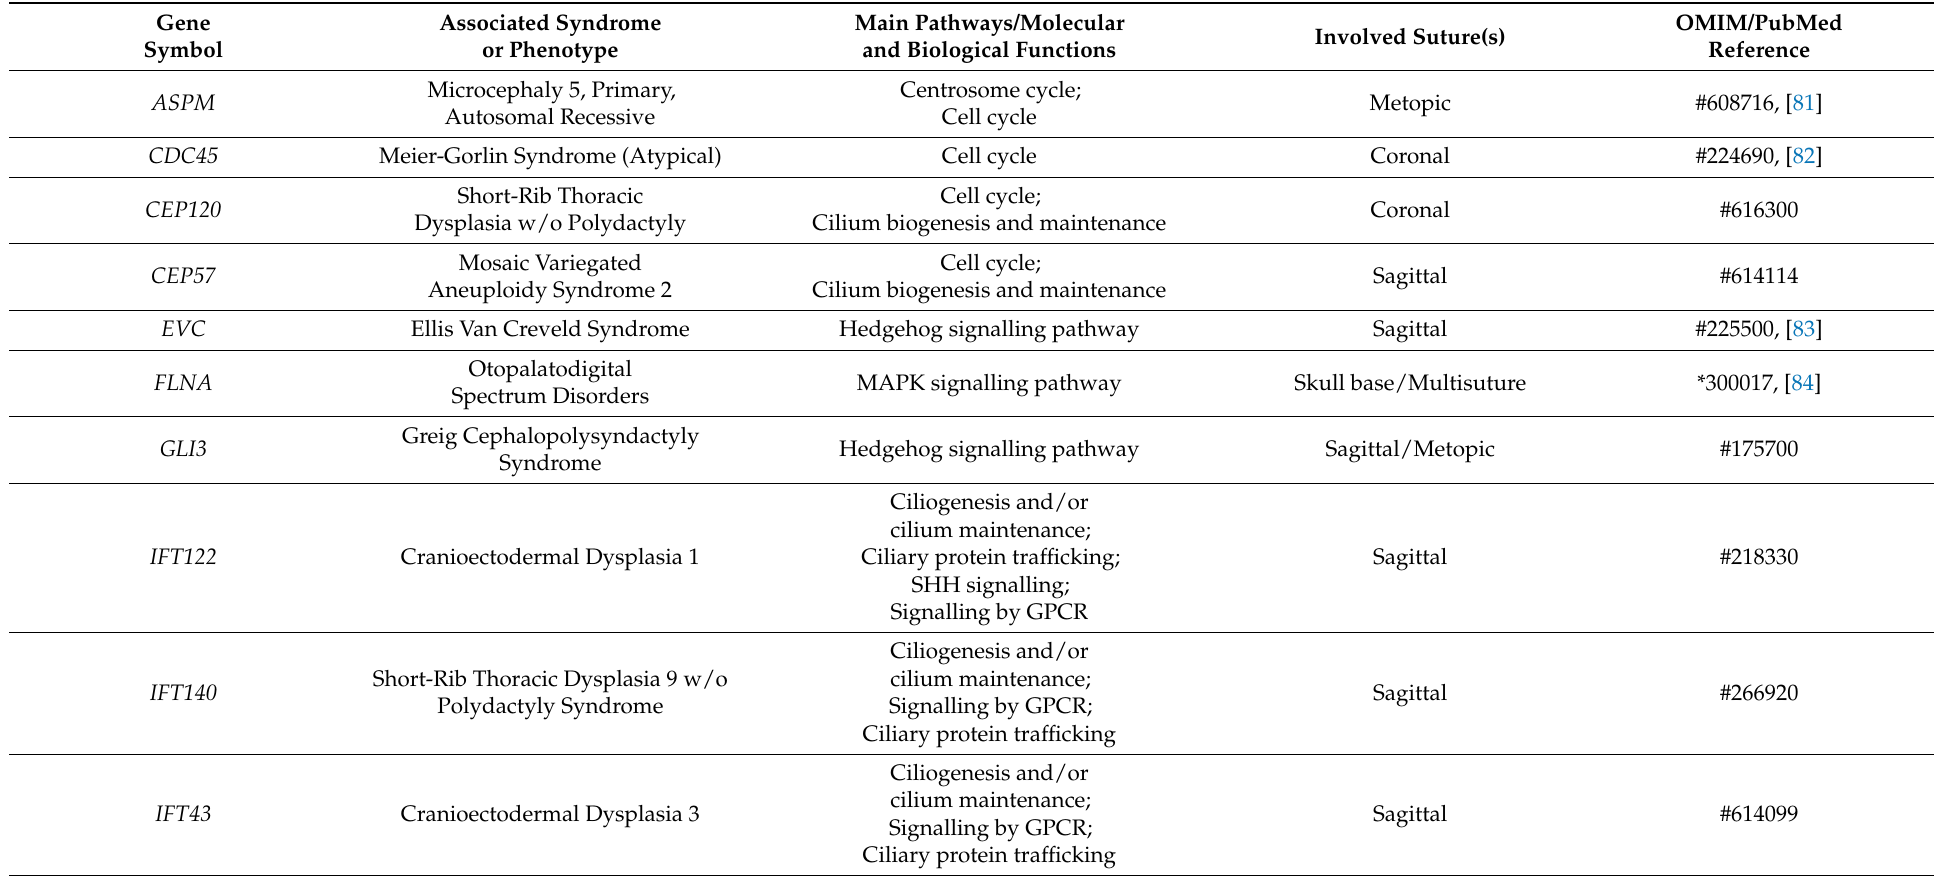
Table 1. Ciliary genes implicated in craniosynostosis